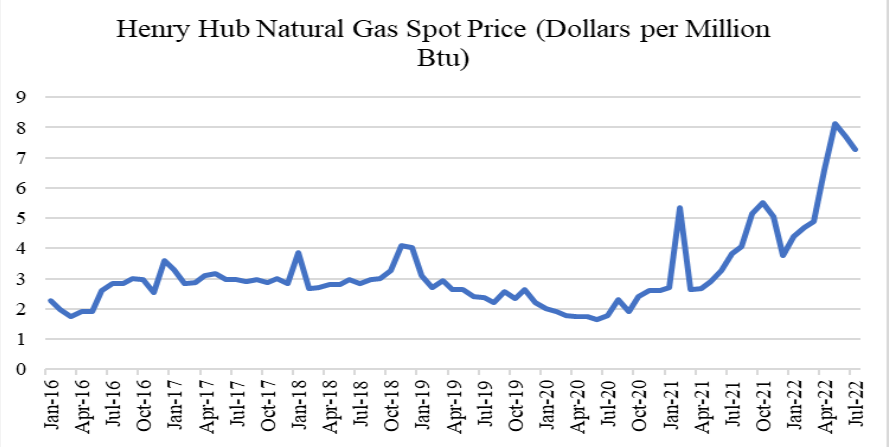
Figure 4. Henry Hub Natural Gas Spot Price. These data can be found here: https://www.eia.com/ (accessed on 20 March 2022).